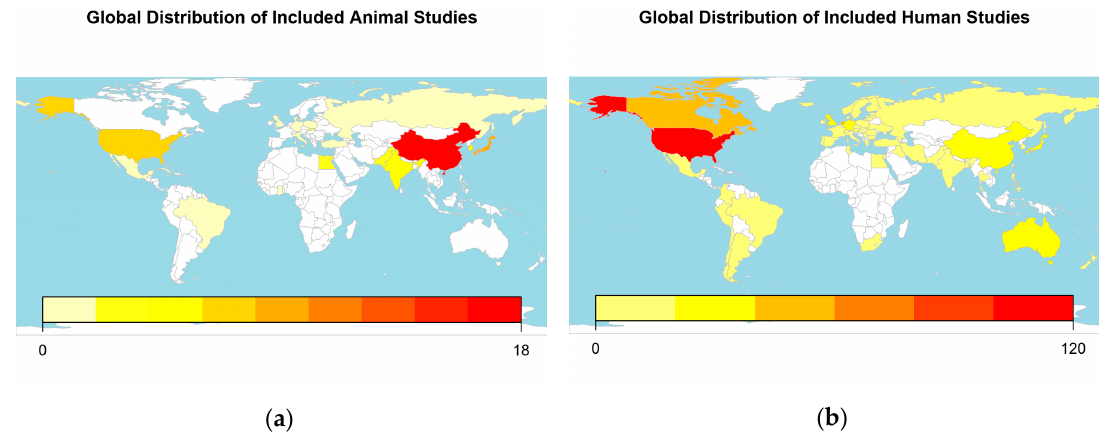
Figure 4. Geographic location. ( a ) World map depicting the locations where the included animal studies were performed; ( b ) world map depicting the locations where the included human studies were performed. The colour reflects the number of studies as indicated in the legend.